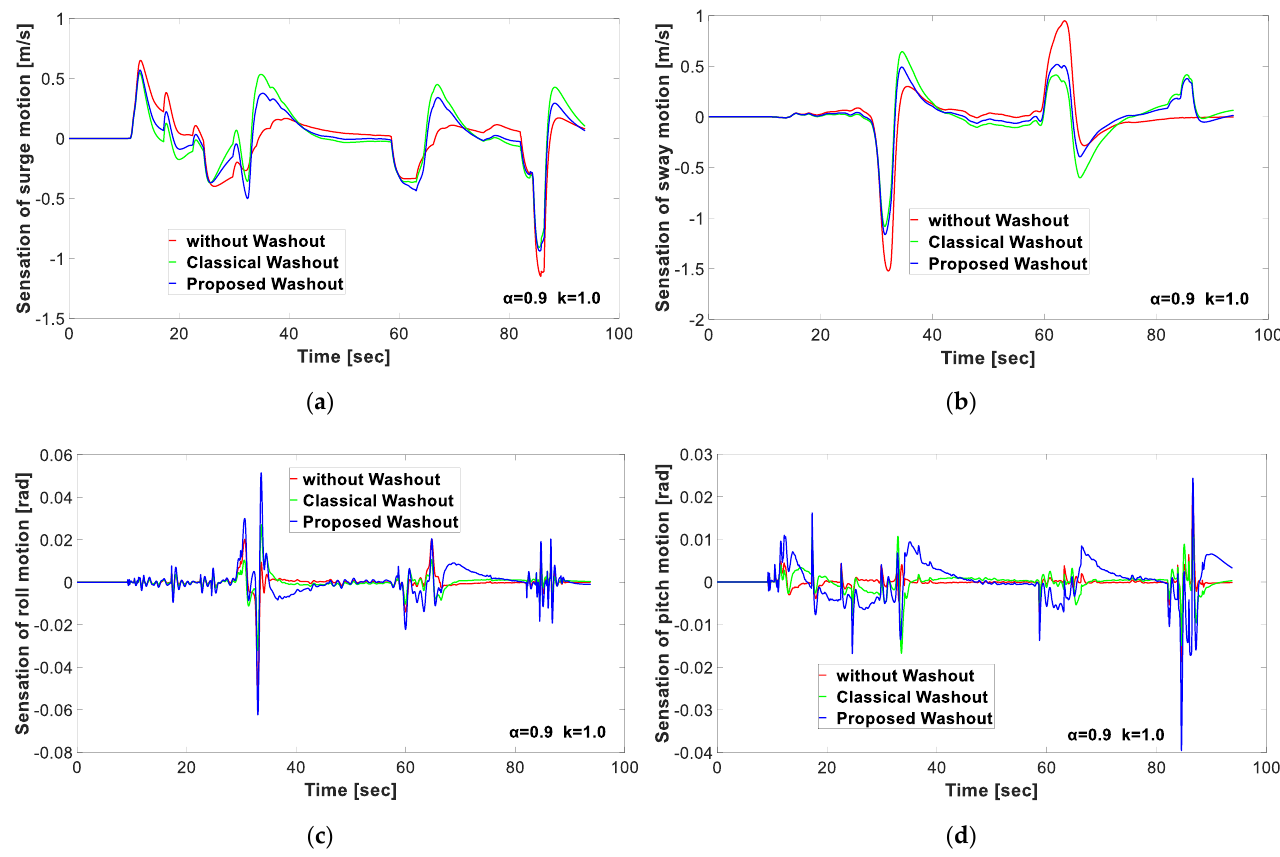
Figure 14. Motion sensation in the case of left ‒ right turn driving. ( a ) Motion sensation of surge direction. ( b ) Motion sensation of sway direction. ( c ) Motion sensation of roll direction. ( d ) Motion sensation of pitch direction.